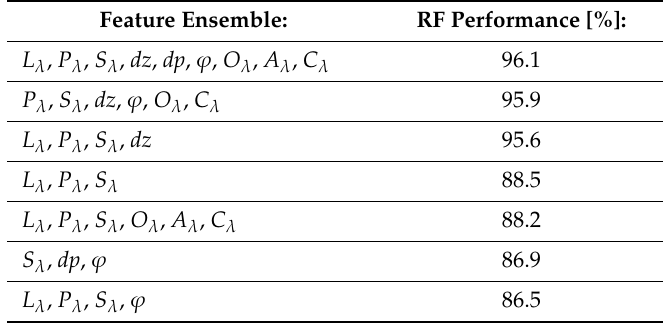
Table 1. Performance of RFs for SAV classification in PCL against manually flagged SAV returns, for SA2 and di ff erent feature ensembles, ordered by performance from top to bottom.